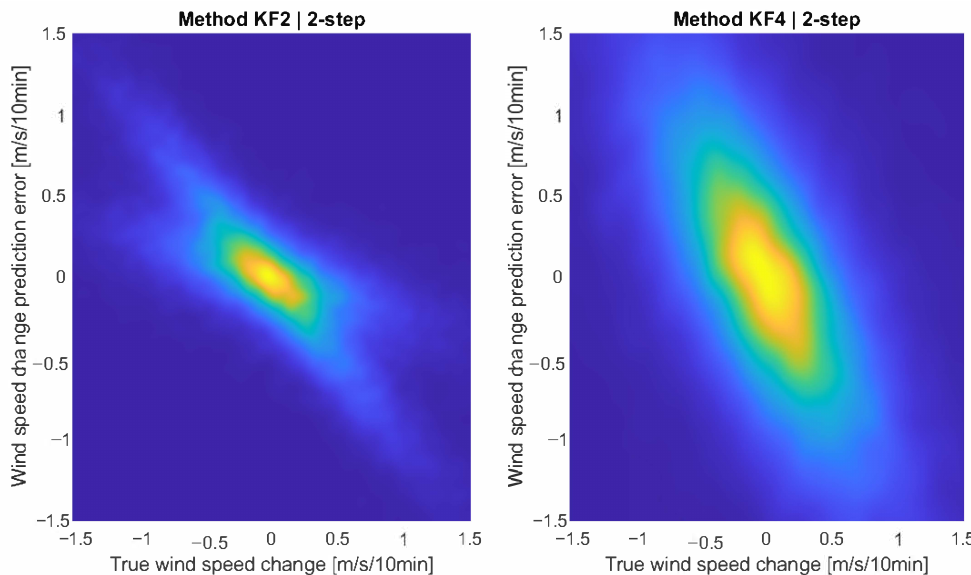
Figure 7. Estimates of the joint probability density functions for variables y (wind speed changes) and δ y (forecast error of wind speed changes) for a forecast horizon of two steps into the future. ( left ) Method KF2, ( right ) KF4.